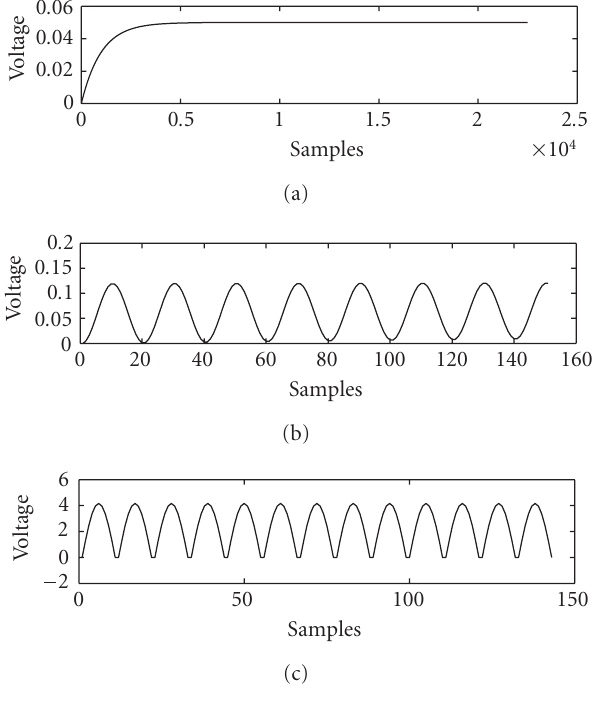
Figure 3.2. Results for the full-wave rectifier.